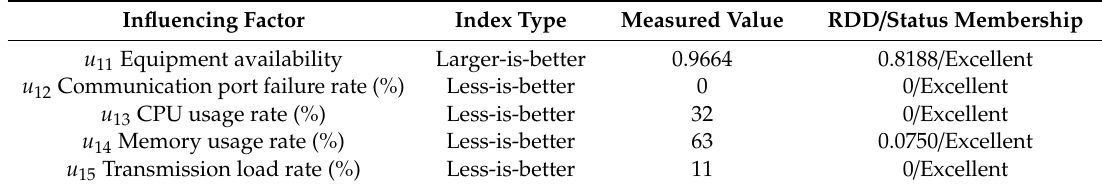
Table 4. Server status data and status evaluation.